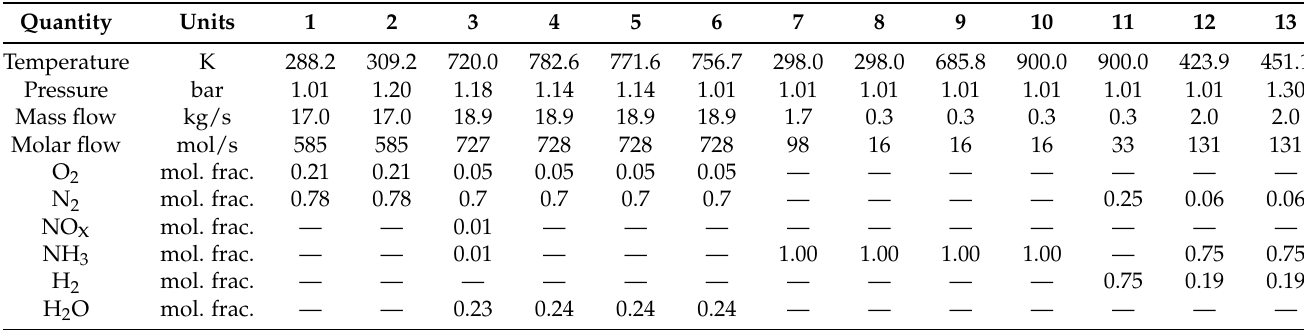
Table 10. The state points corresponding to the process flow diagram given by Figure 13 for an ICE 13.4 MW gas carrier at MCR.